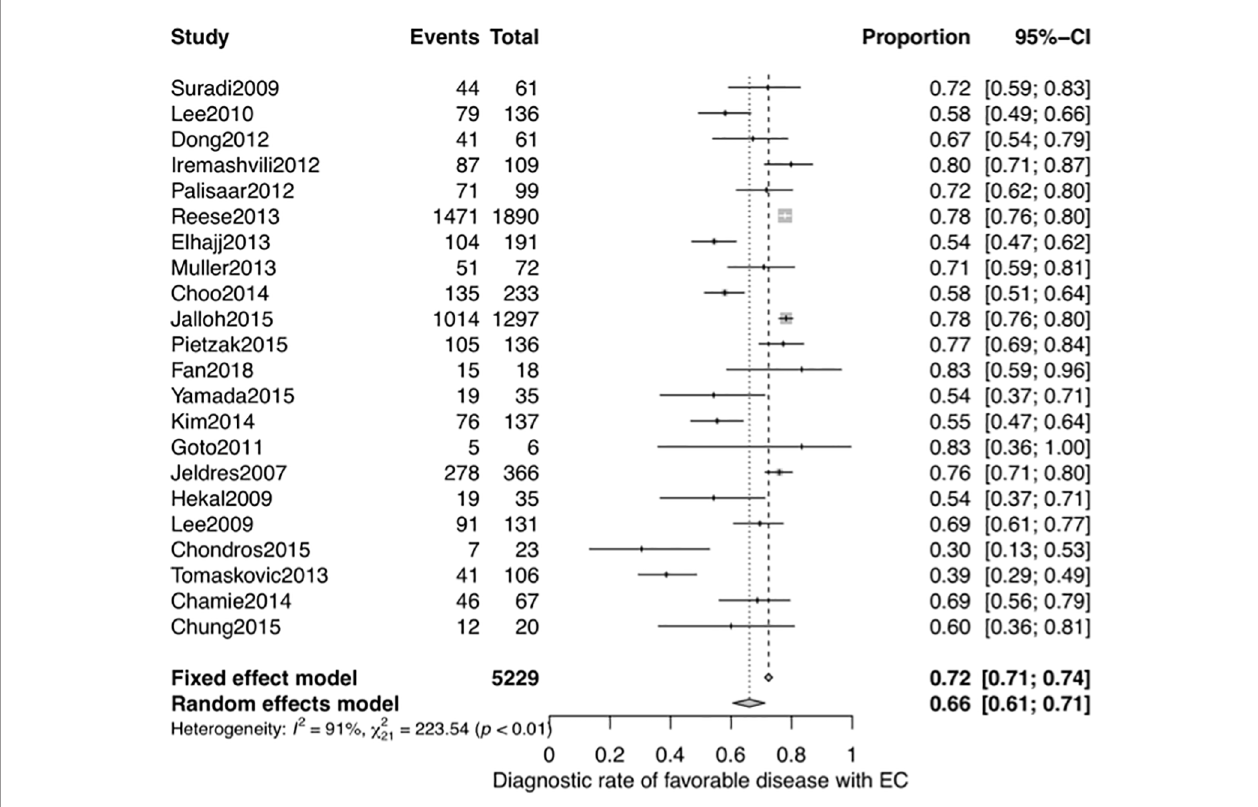
FIGURE 6 | Forest plot of studies that explored the diagnostic accuracy of the EC for favorable